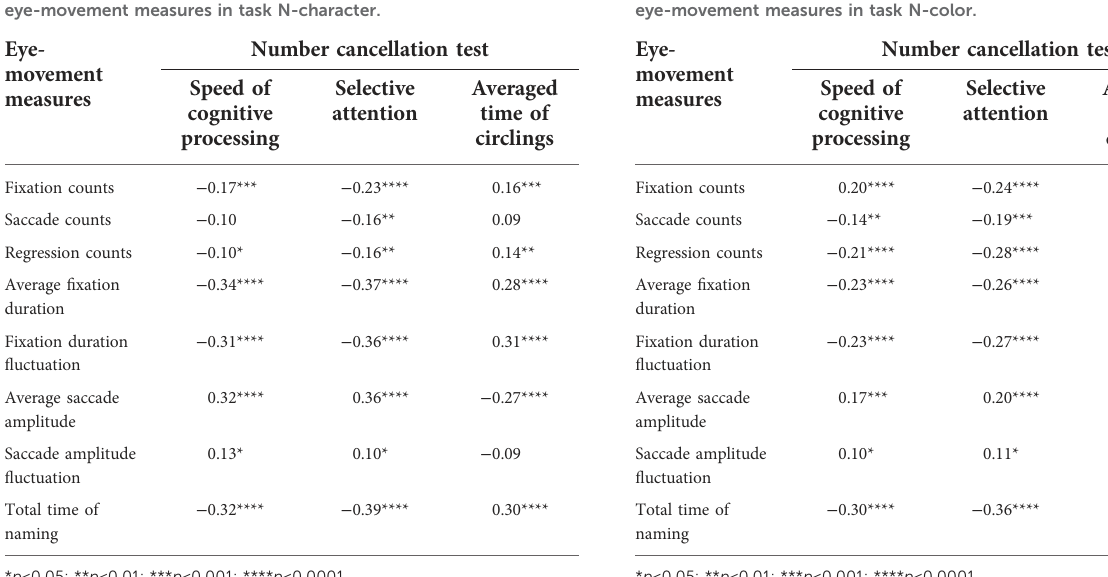
TABLE 4 Correlation between number-cancellation-related skills and eye-movement measures in task N-character.